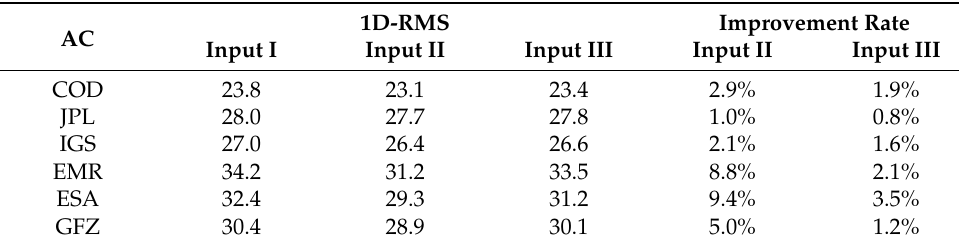
Figure 8. 1D ‐ RMS statistics of the dynamic orbit (unit: mm). Figure 8. 1D-RMS statistics of the dynamic orbit (unit: mm). Table 6. Statistic of differences in LEO dynamic orbit 1D ‐ RMS accuracy between boundary and non ‐ Table 6. Statistic of differences in LEO dynamic orbit 1D-RMS accuracy between boundary and boundary (unit: mm). non-boundary (unit: